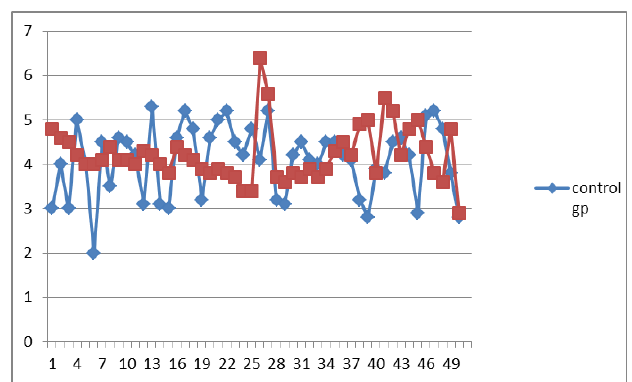
Figure(12): Shocked patients received normal saline group versus shocked patients received furosemide group,in term of central venous pressure CVP,there is no significant statistical diffrence(p=0.176).